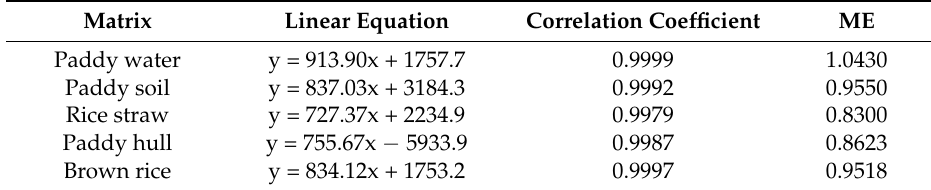
Table 1. Linear equations, correlation coefficients (R 2 ) and matrix effect (ME) determined for paddy water, paddy soil, rice straw, paddy hull, and brown rice.